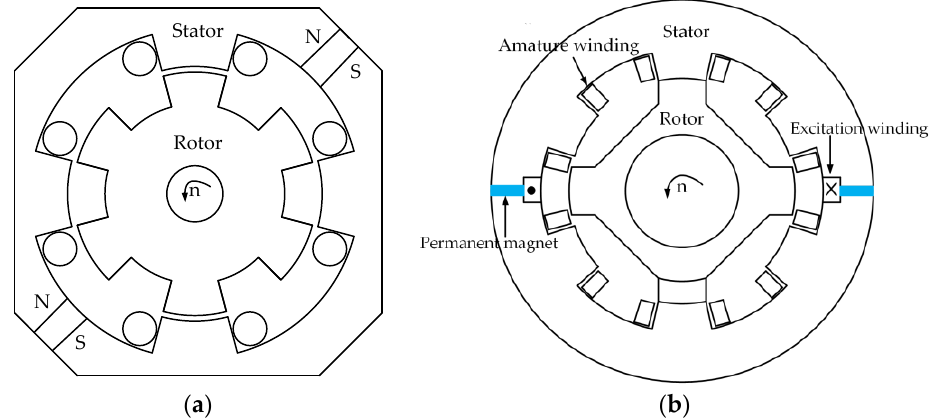
Figure 2. ( a ) DSPM machine [22]. ( b ) HEDSM machine [23].